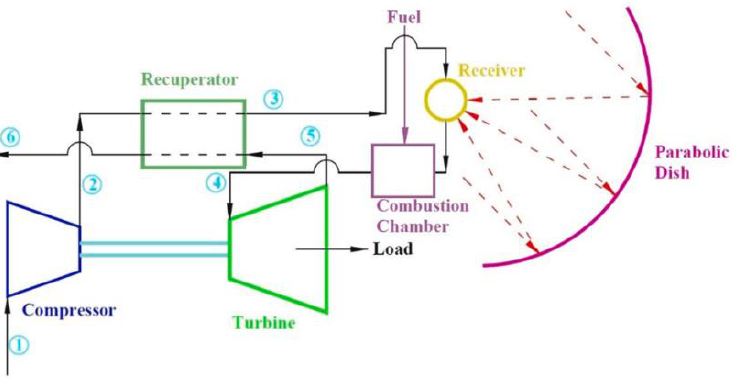
Figure 10. Hybrid MGT-solar dish plant [104].